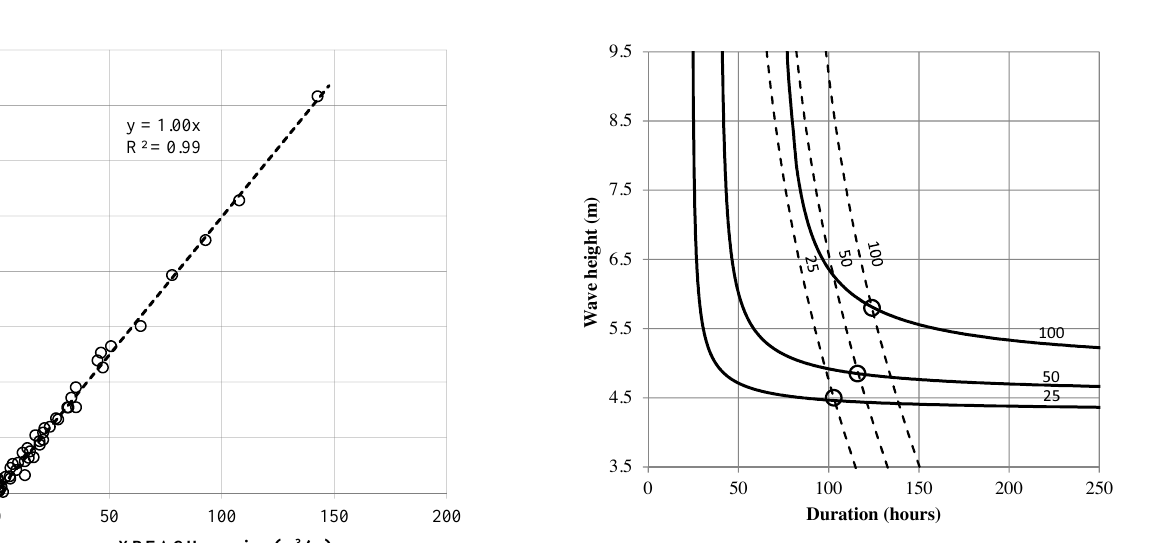
Fig. 7. Level curves of storm parameters H and D for storm (solid Figure 7: Level curves of storm parameters H and D for storm (solid lines) and lines) and erosion (dashed lines) return periods of 100, 50 and 25yr erosion (dashed lines) return periods of 100, 50 and 25 year for T = 15 s and for T = 15s and W = 1 . 0m above mean sea W = 1 . 0 m.